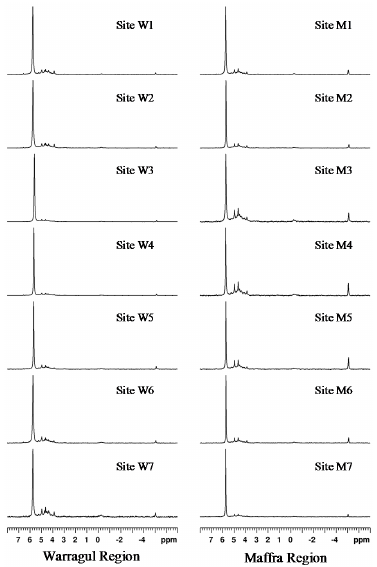
Figure 2. Solution 31 P NMR spectra of NaOH-EDTA soil extracts.